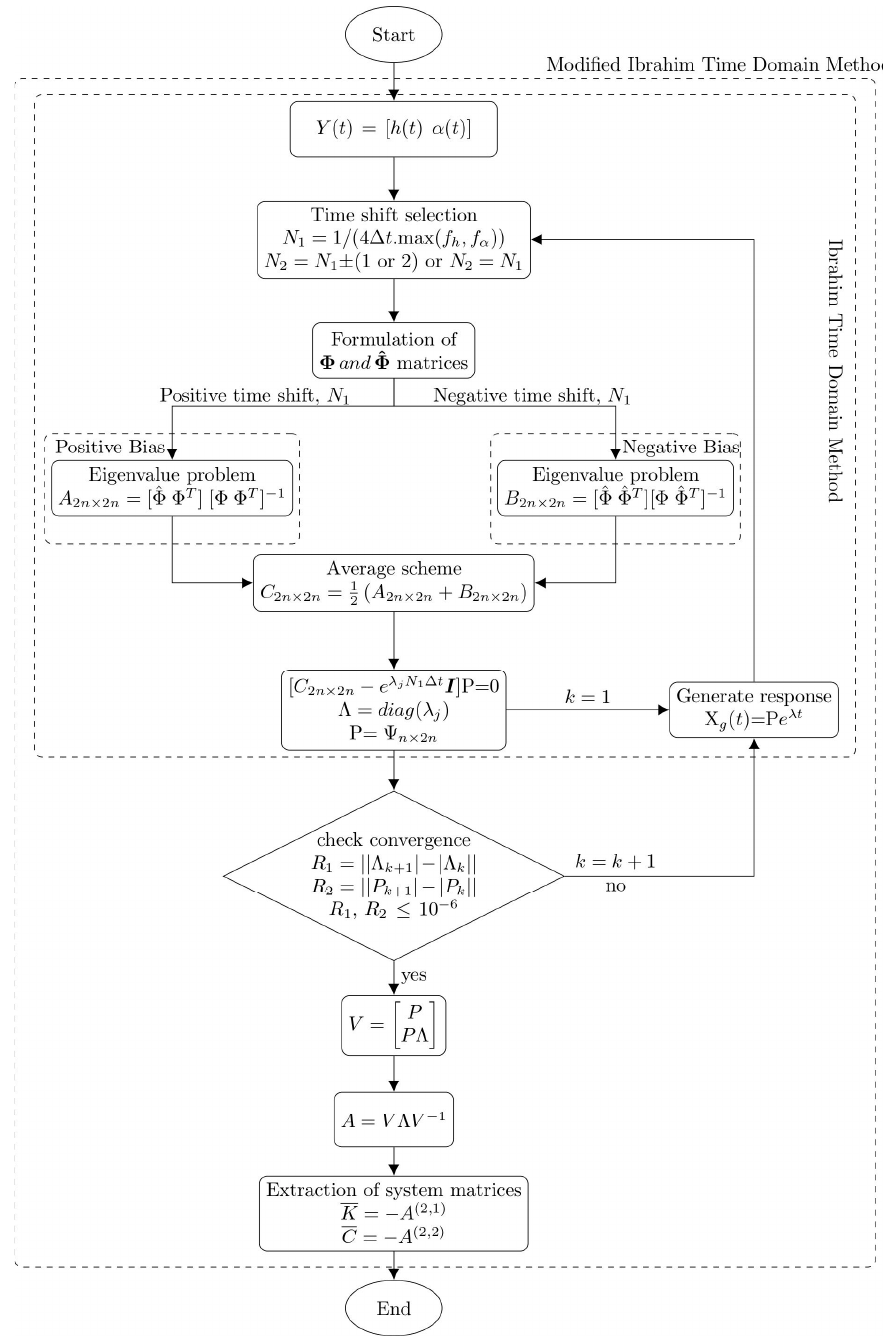
Figure 4. Flowchart of the modified Ibrahim time domain method (MITD) algorithm.